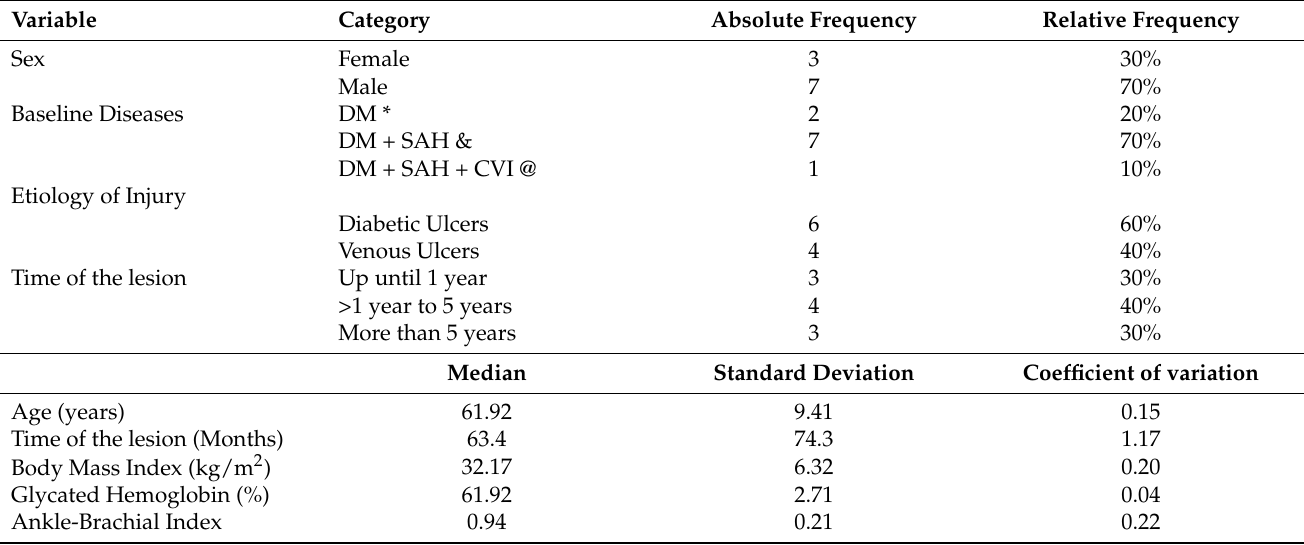
Table 1. The main statistics of the sociodemographic and clinical variables of the patients at the baseline.